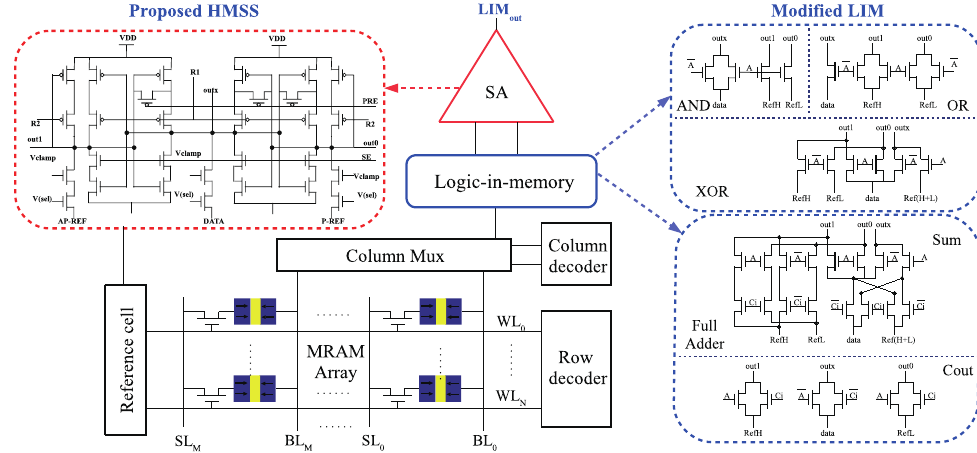
Figure 10. HMSS-SA with improved sensing margin applied to the modified logic-in-memory scenario.